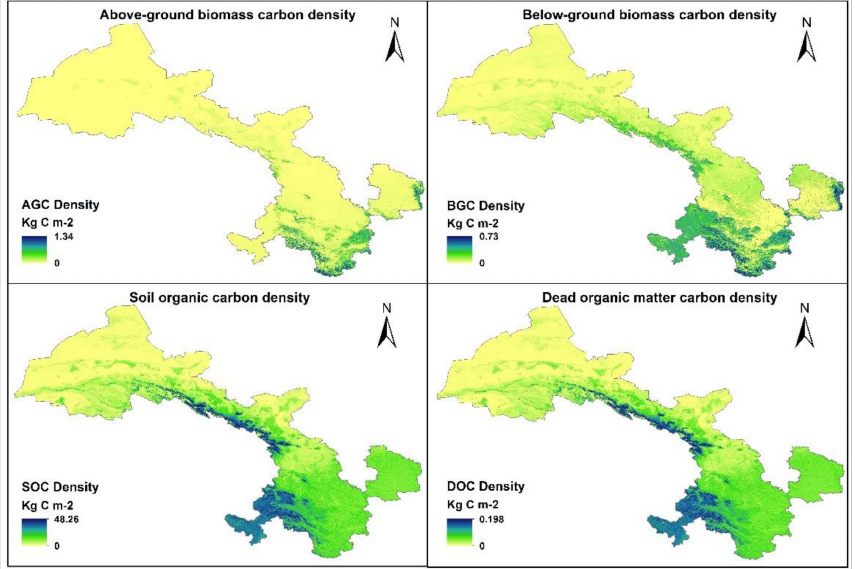
Figure 2. Spatial distribution of terrestrial ecosystem carbon density of the Gansu